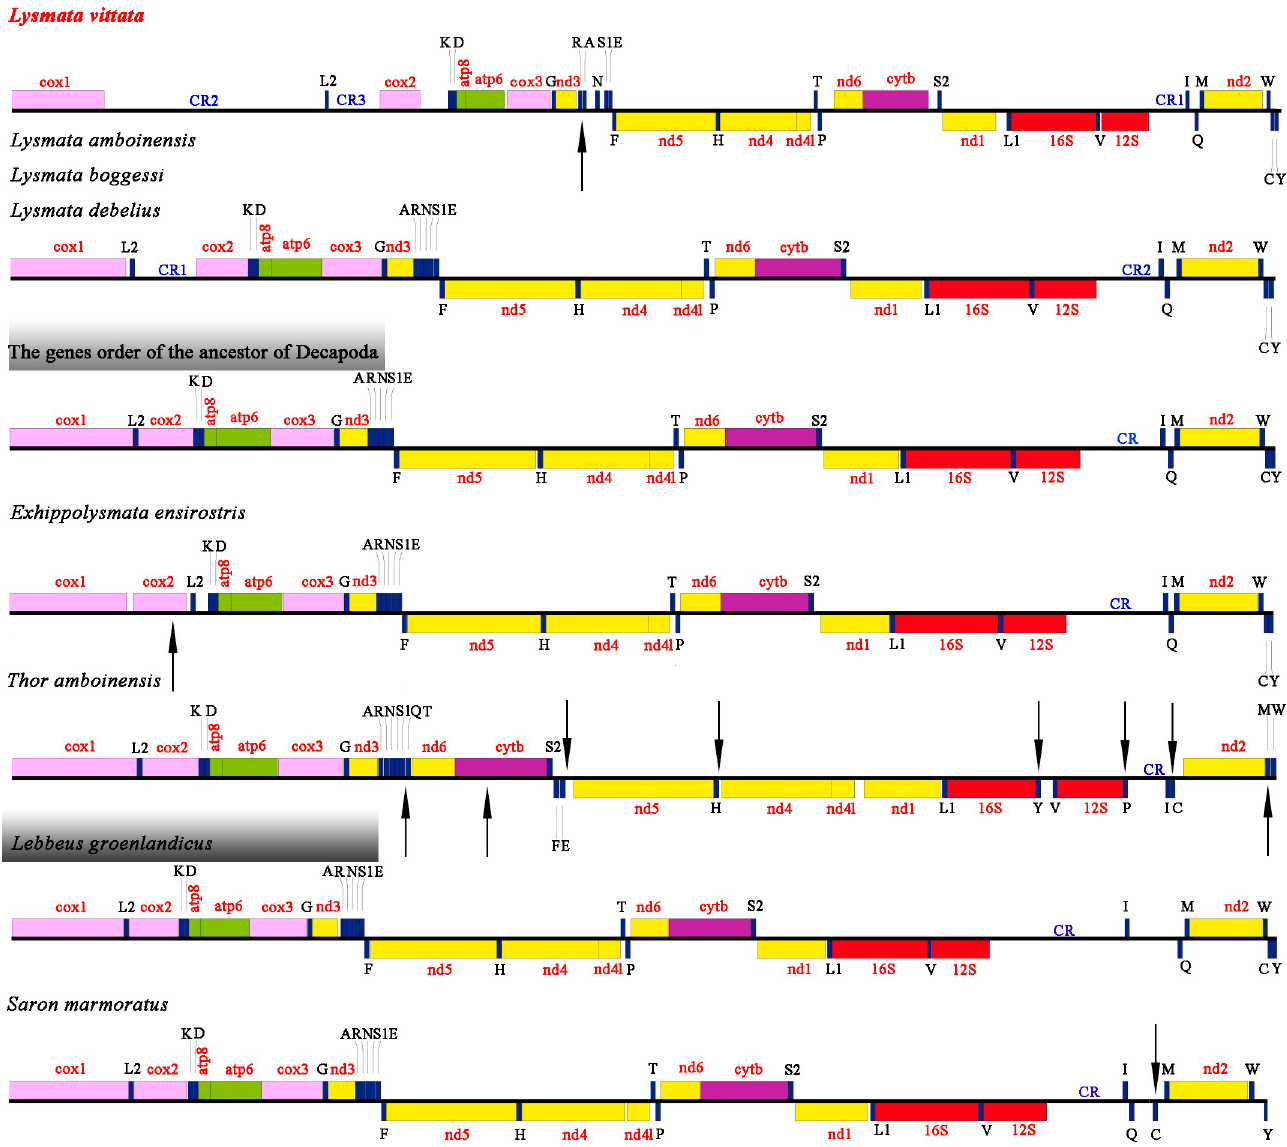
Fig 3. Linear representation of gene rearrangements of Hippolytidae